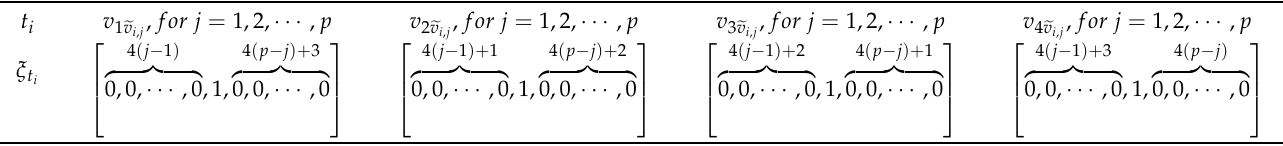
Table 6. ξ for VFCSS over applying over TFN-type fuzzy numbers when metric (14) is used.